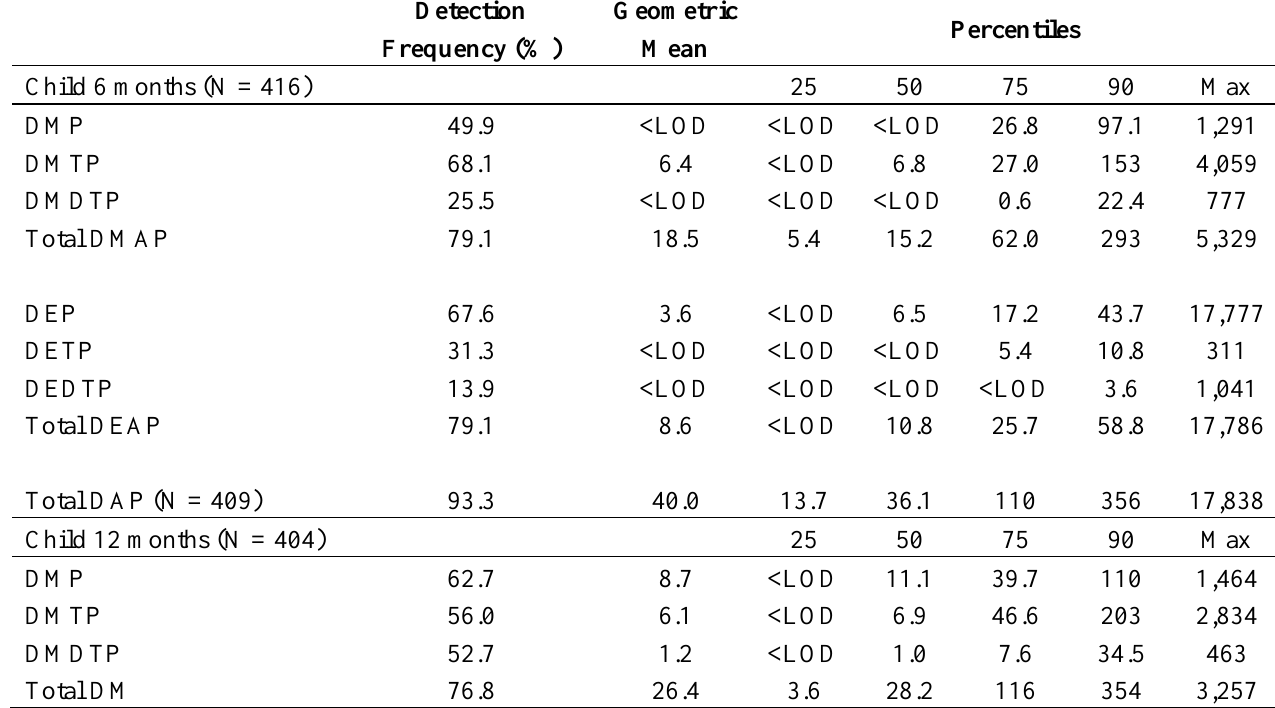
Table 2. Children’s urinary DAP metabolite levels at three time points, at 6, 12 and 24 months (nmol/L) a